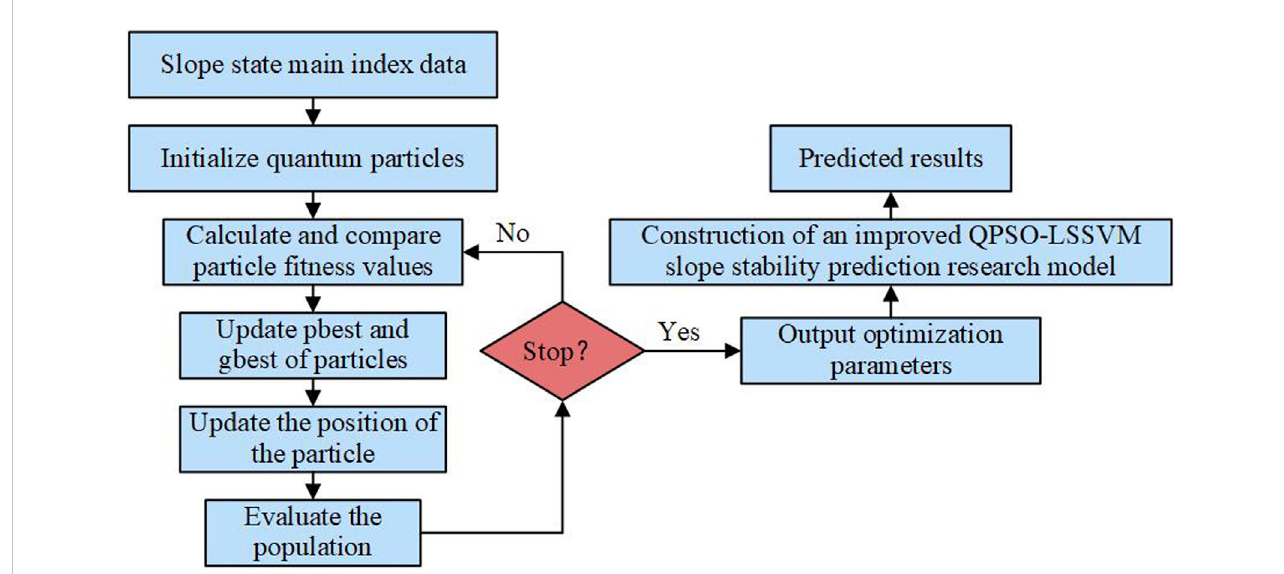
FIGURE 2 Flow chart of ACE-QPSO optimized LSSVM